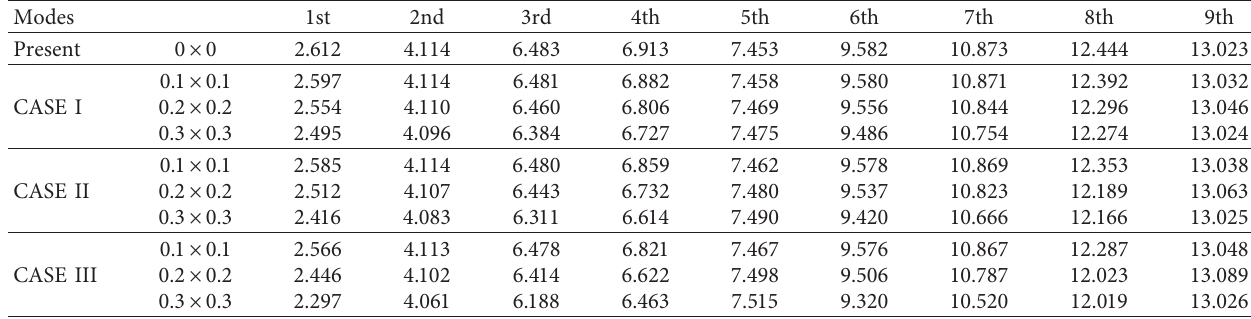
Table 3: Nondimensional frequencies of the cross-ply laminate ([0/90]s) with CCCC boundary condition, E 1/ E 2 � 10, a � 2b, and b � 10h and for different patch sizes and numbers.